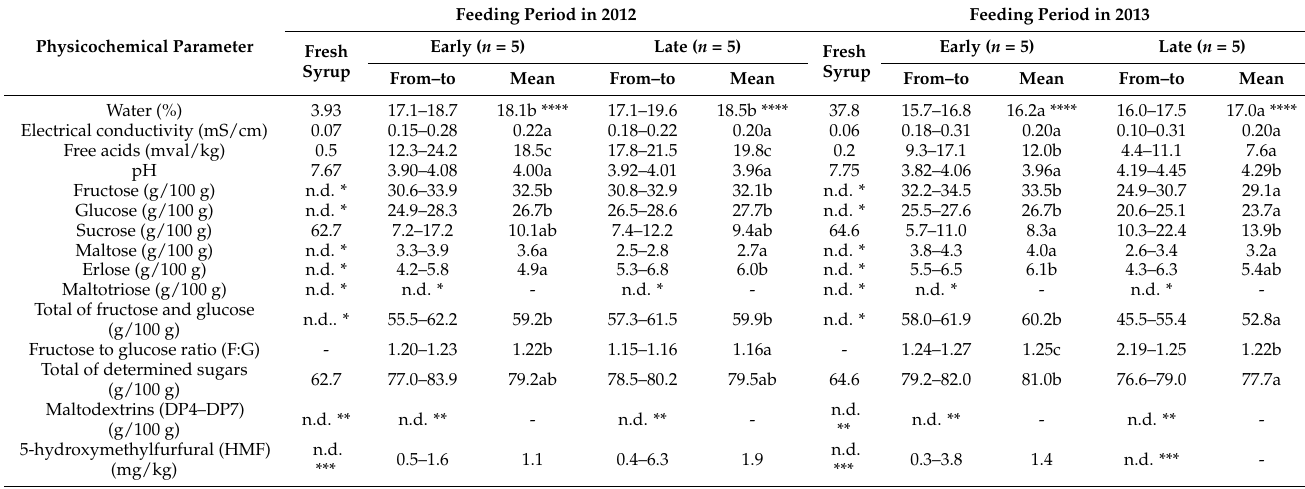
Table 4. Physicochemical composition of winter stores produced by bees fed with homemade saccharose syrup.